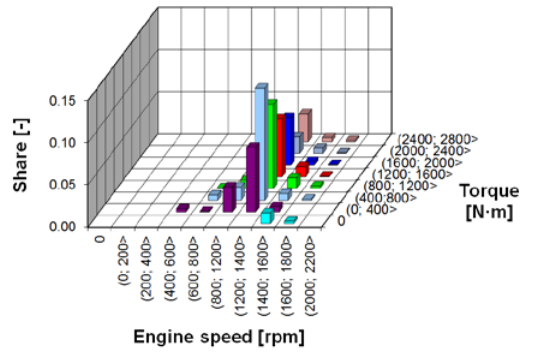
Fig. 5. Characteristics of the operating time share in the ranges of engine speed and load